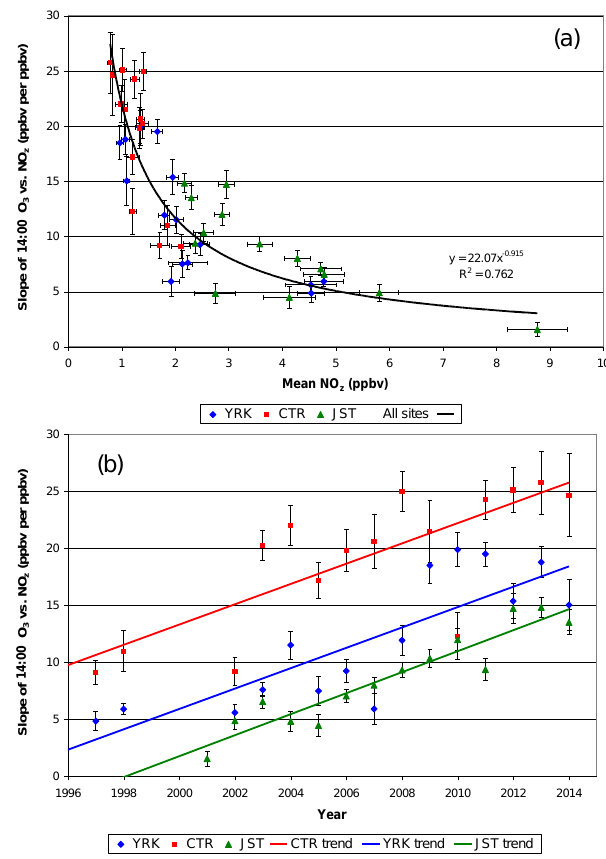
Figure 10. (a) Summer CTR, JST, and YRK slope of daily (14:00) O 3 and NO z vs. mean (14:00) NO z mixing ratios and (b) summer regression slope vs. year. NO 2 data were not available for 1999 through 2001. Vertical and horizontal error bars are 1 standard er- ror of the regression slopes and 1 standard error of the NO z means, respectively. Mean NO z measurement uncertainty is estimated as 0.2ppbv (1 σ